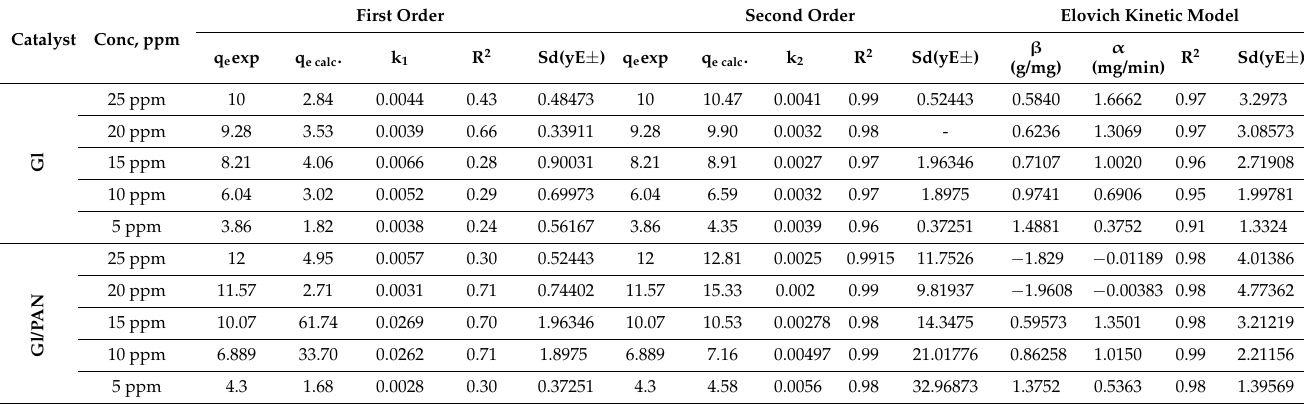
Figure 7. ( a , b ) Pseudo-first-order, ( c , d ) Pseudo-second-order, and ( e , f ) Elovich sorption kinetics of CR dye at 25 °C and pH 7 by 20 mg of ( a , c , e ) Gl and ( b , d , f ) Gl/PAN. Table 3. Parameters of the kinetic models for CR dye adsorption on Gl and The CR adsorption onto Gl and Gl/PAN adsorbents is well handled with the Pseudo- second-order diffusion model and this appears in the higher R 2 values from 5 ppm to 25